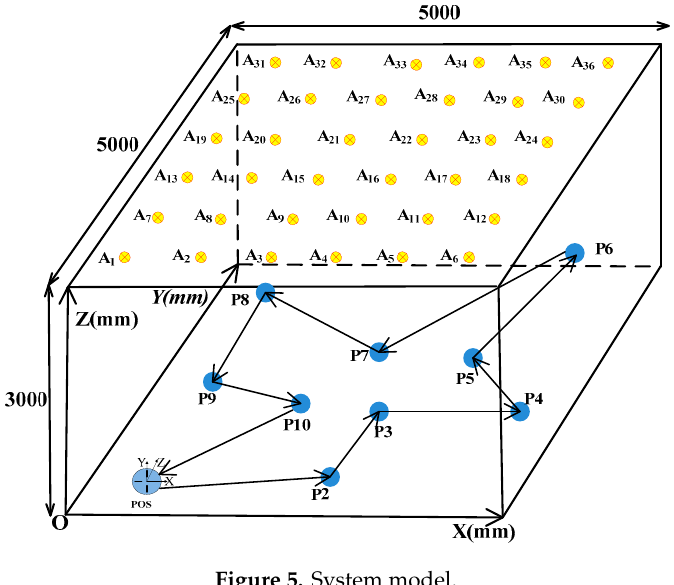
Figure 5. System model.